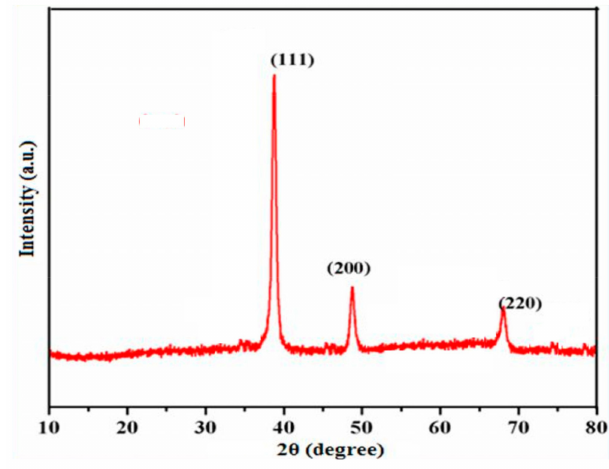
Figure 6. XRD Studies of Cu(II)-AEA NPs mediated copper nanoparticles.